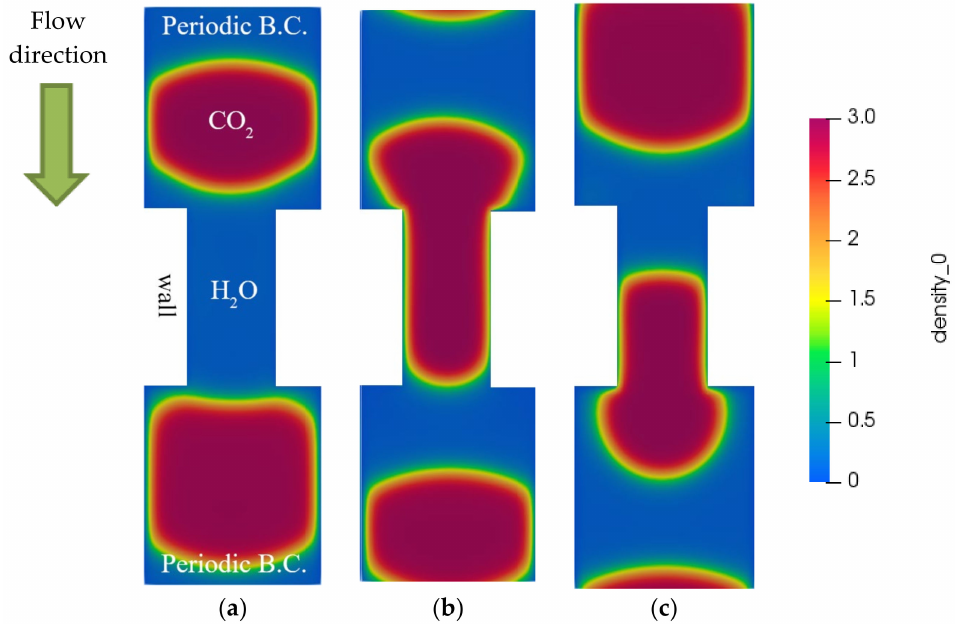
Figure 4. CO 2 bubble passing through a narrow channel with a density ratio of 4 at G f = 4.8 × 10 − 5